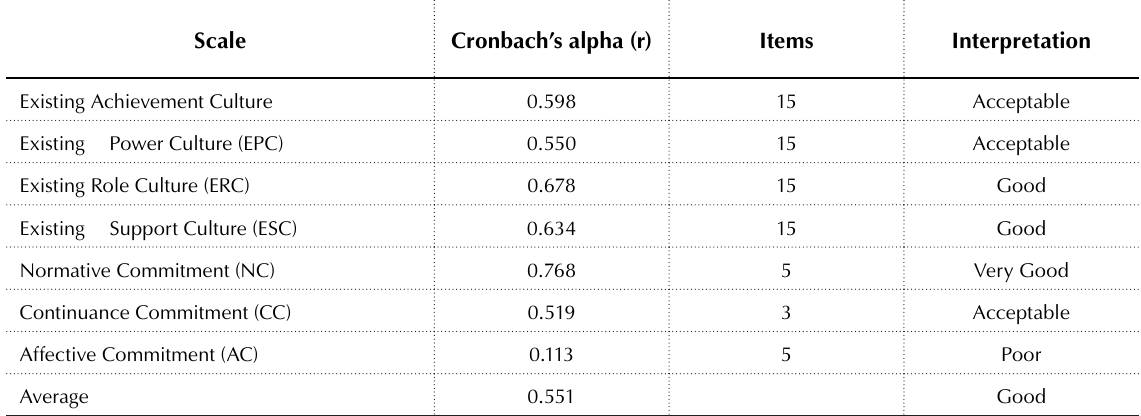
Table 1. Reliability of the existing organizational culture and organisational